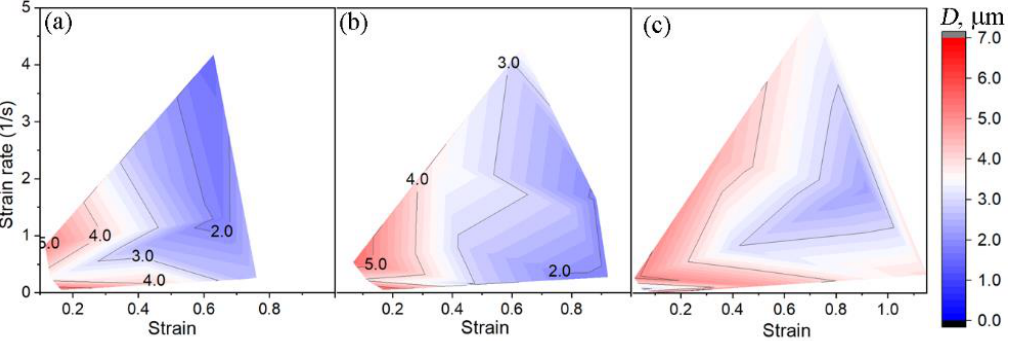
Figure 9. The effect of strain and strain rate on the average grain diameter depending on temperature, °C: ( a ) 300, ( b ) 400, ( c ) 500. The dependences are plotted from the results of the EBSD analysis of the microstructure.